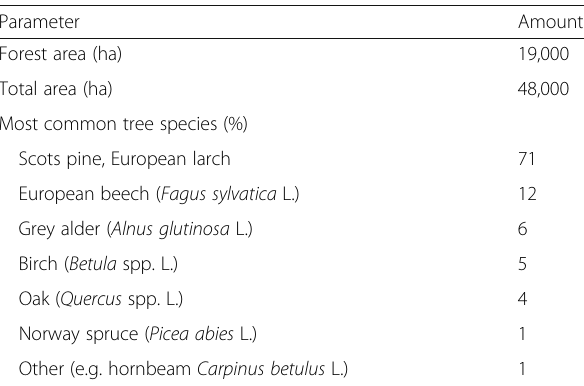
Table 1 Basic information about the Mi ł om ł yn Forest District (source: